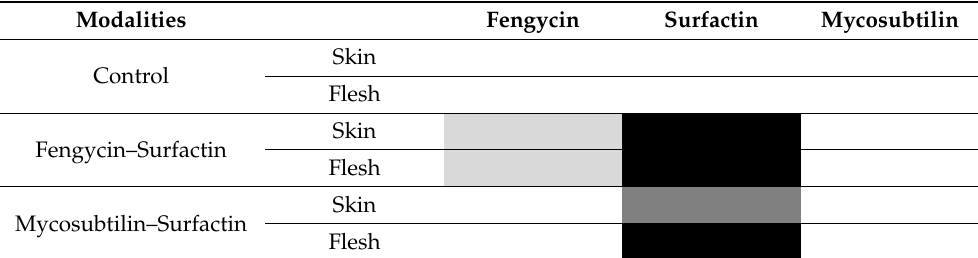
Table 4. Quantification of fengycin, surfactin and mycosubtilin following extraction by the QuEChERS method in the different samples by RP-UPLC-MS 1